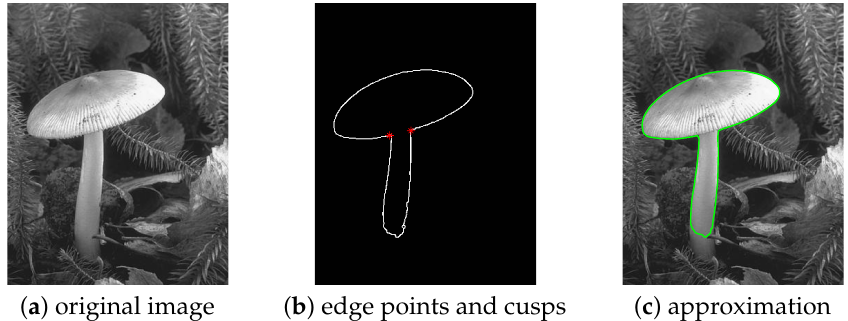
Figure 7. Recognition and approximation of a mushroom. From the original image ( a ), we extract ( b ) and approximate the edge points ( c